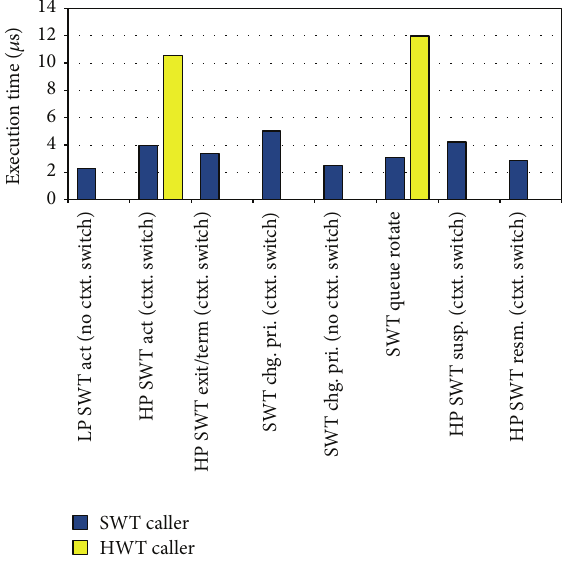
Xilinx Virtex-II FPGA. That system also contains PPC405 CPU; however, it runs at 300 MHz, that is, three times faster than the CPU used in our tests. Similarly to our system, that work uses a PLB bus for data communication and a DCR bus to control the HW task’s OS interface. The buses and the HW